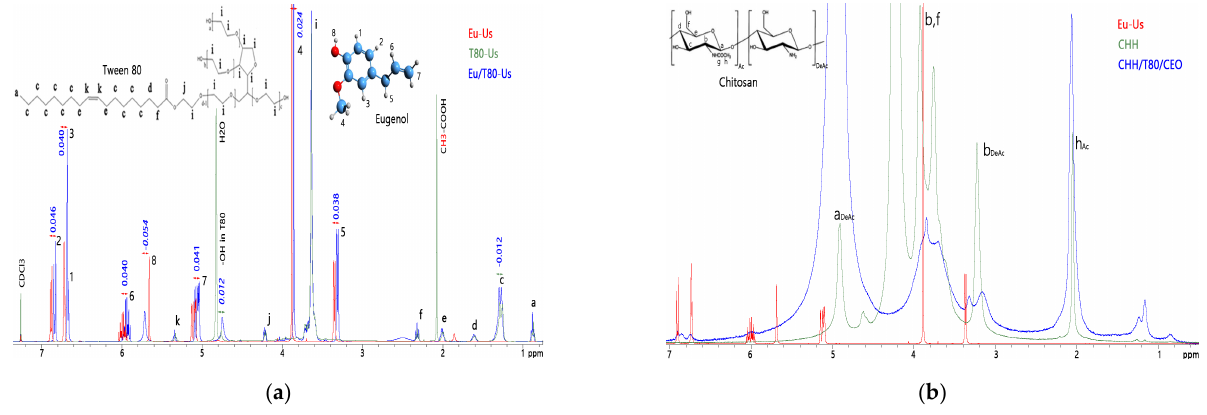
Figure 7. 1 H-NMR spectra of eugenol (Eu) and of Tween 80 (T80) ultrasonicated (Us) in acetic acid individually or together ( a ) and of the obtained CHH and CHH/T80/CEO hydrogels ( b